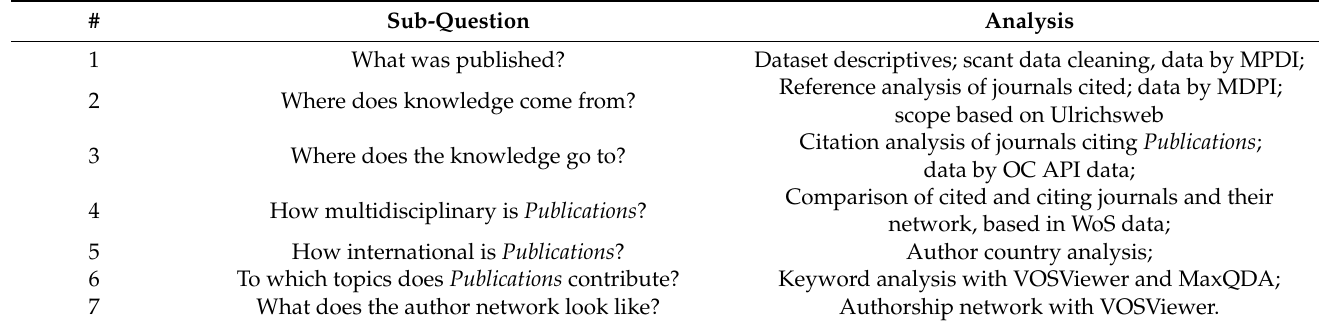
Table 1. Bibliometric analysis to inform our research